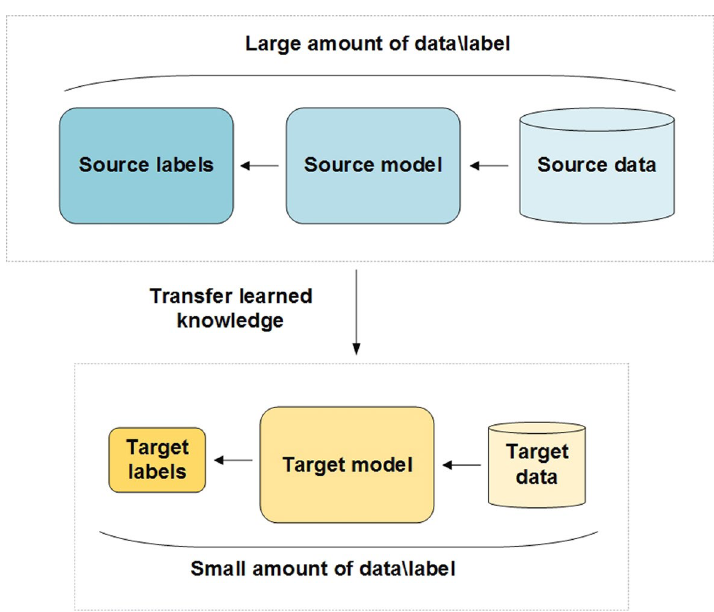
Fig. 6 General concept of